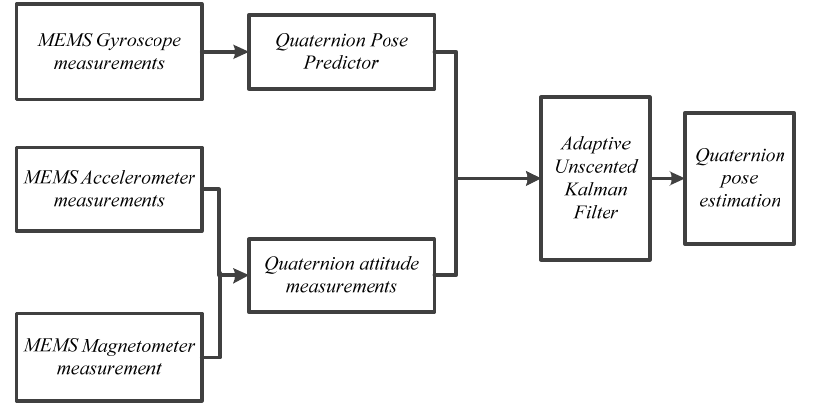
Figure 3. The adaptive UKF algorithm.